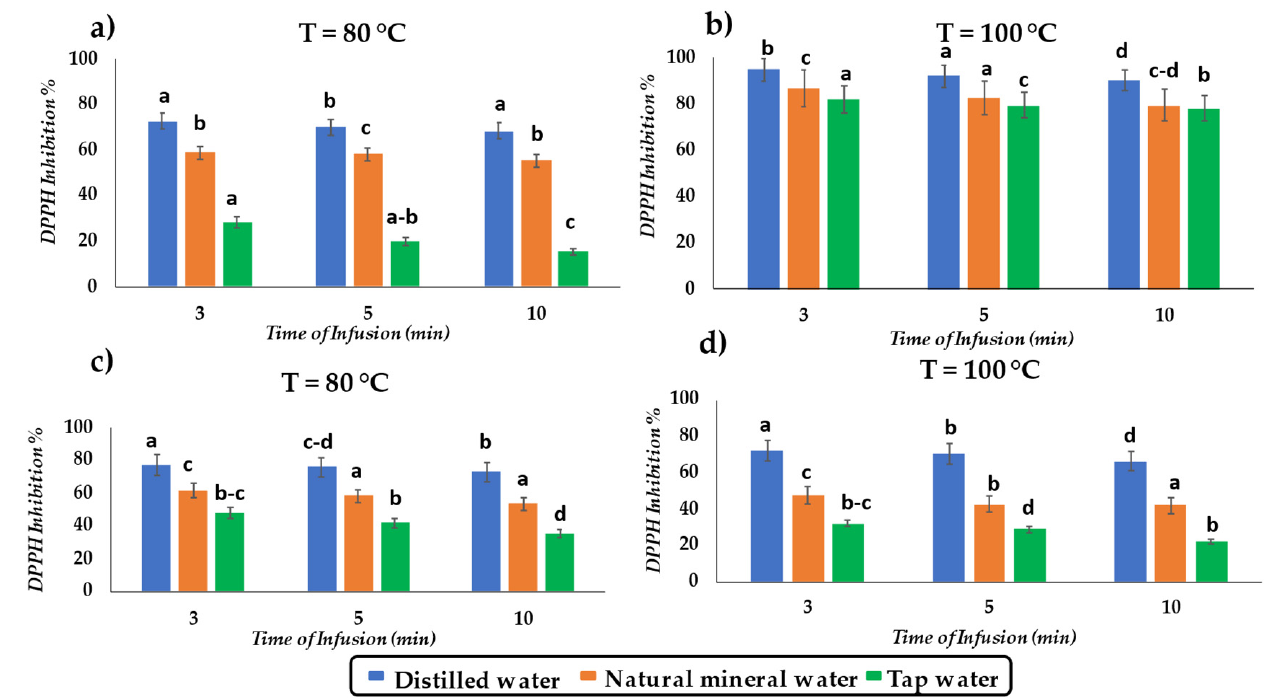
Figure 7. DPPH radical scavenging activity of green tea infusion ( a , b ), at T = 80 ◦ C ( a ) and at T = 100 ◦ C ( b ); and of black tea samples ( c , d ) at T = 80 ◦ C ( c ) and at T = 100 ◦ C ( d ); in distilled water, in natural mineral water, and in tap water. Error bars are ± standard deviation. Same letters indicate a significant difference according to the ANOVA test ( p < 0.05).